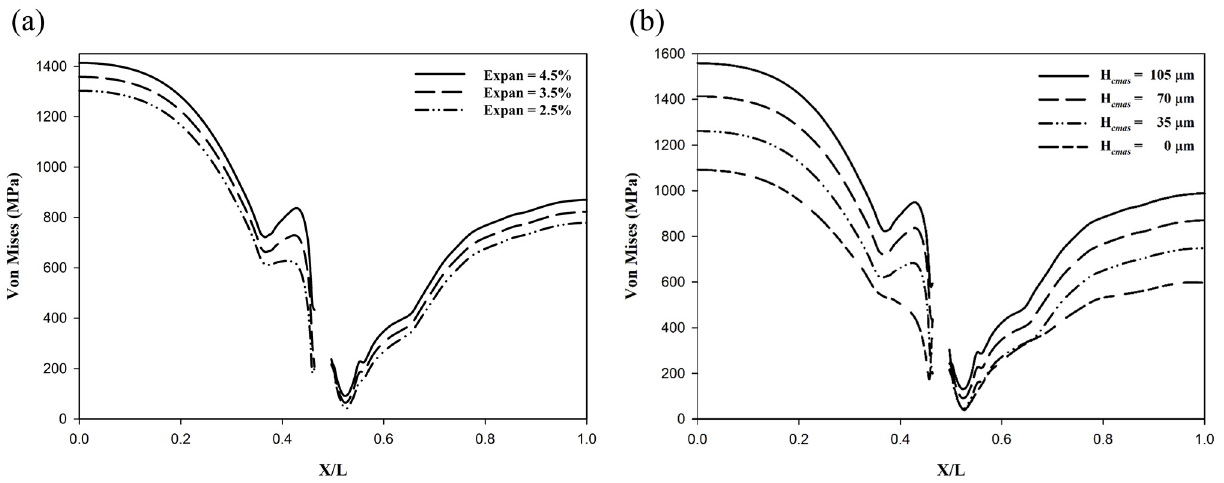
Figure 9. Von Mises stress with ( a ) different expansion rates and ( b ) penetration depth along BC top surface.